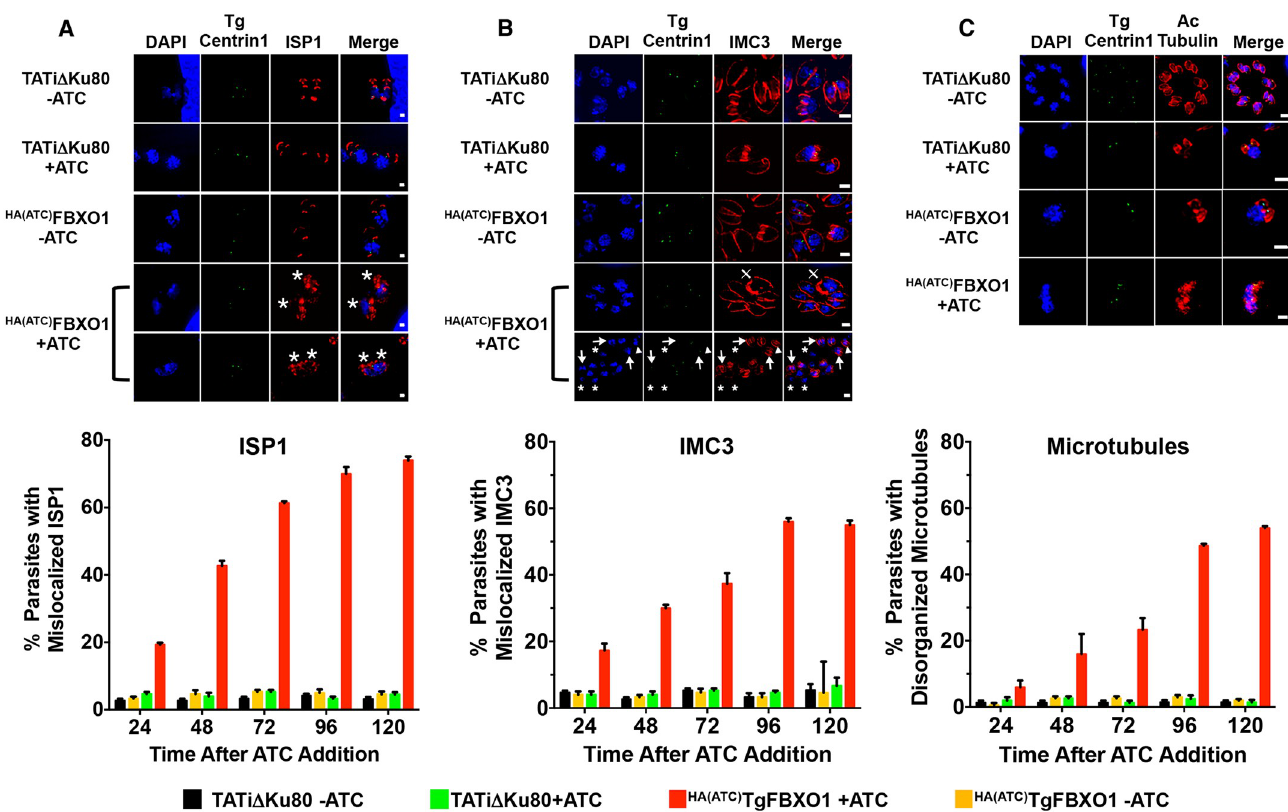
Fig 7. TgFBXO1 is required for IMC organization and maturation. (A-C) . Parental RH Δ hxgprt Δ Ku80 and HA(ATC) TgFBXO1 parasites were grown for 1–5 days in the absence or presence of ATC (1 μ g/ml) and stained to detect DNA (blue), centrin (green), and ISP1, IMC3, or acetylated tubulin (red). Images are of representative parasites 5 days -/+ ATC. Graphs below each panel represent averages and standard deviations from 3 independent experiments with at least 50 parasites counted per condition. Bars = 2 μ m. (A). � denotes mislocalized ISP1 in DCS of parasites with decreased TgFBXO1 expression. Bars = 1 μ m. (B). highlights IMC3 whirls, � highlights parasites lacking IMC3 staining, arrows highlight misaligned IMC3 and centrin1, and arrowheads highlight parasites lacking centrin1 staining. Bars = 2 μ m. (C) . Note disorganized appearance of acetylated microtubules in ATC-treated HA(ATC) TgFBXO1 parasites. Bars = 2 μ m.